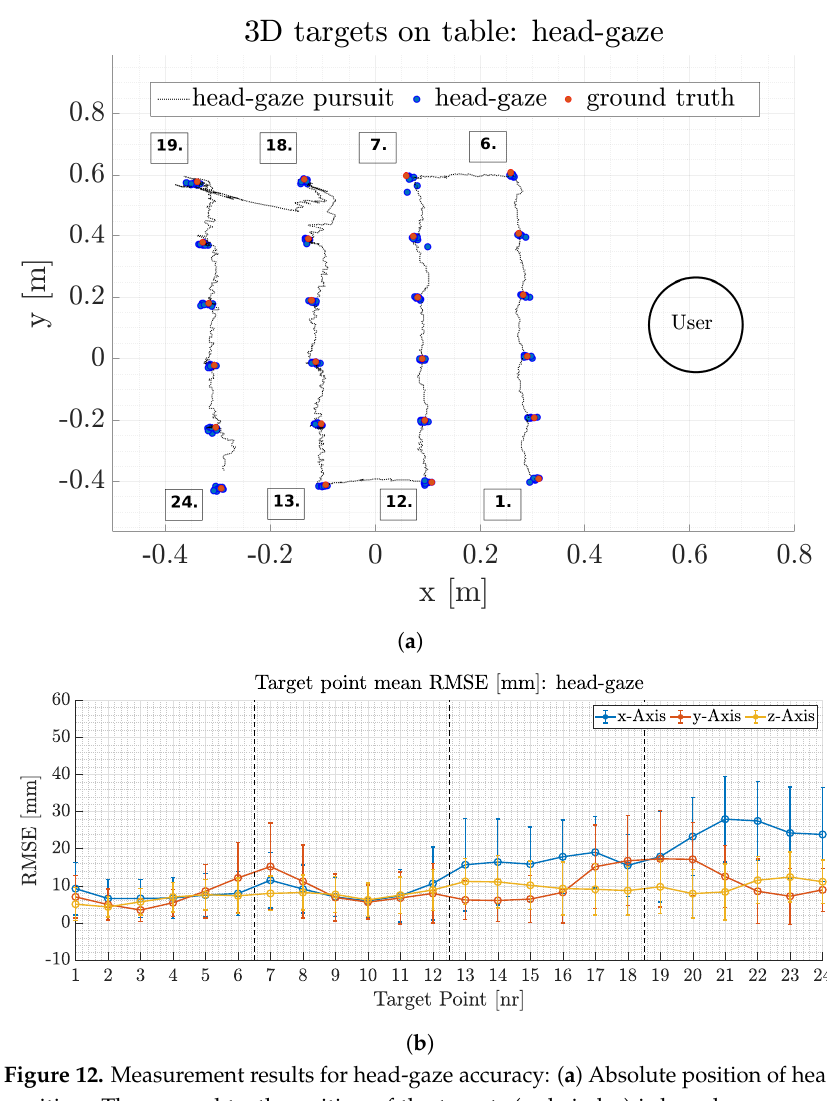
Figure 12. Measurement results for head-gaze accuracy: ( a ) Absolute position of head-gaze on target position. The ground truth position of the targets (red circles) is based on pre-recorded Qualisys measurements. The head-gaze positions are depicted as blue circles. The head-gaze trajectory (switching between targets) is marked with a dotted black line. The users approximate position is represented as a black circle. Figure ( b ) depicts mean head-gaze error for each individual axis along target points throughout all trials. The black dashed lines indicate separation of the target groups for all four